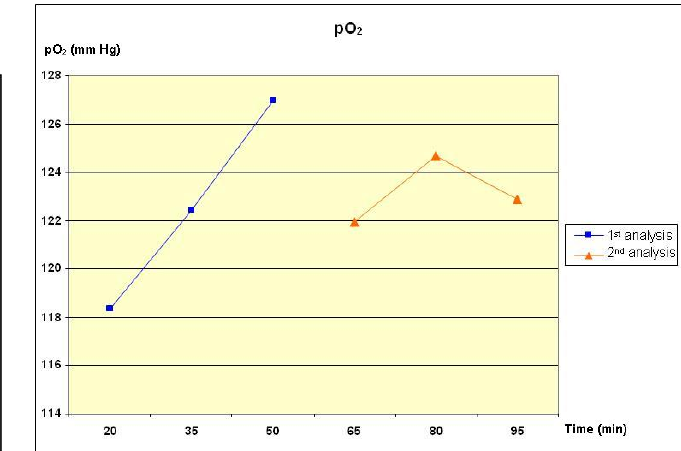
FIGURE 1 – pCO average values in the first and second gasometrical 2 analysis during the blood storage on ice